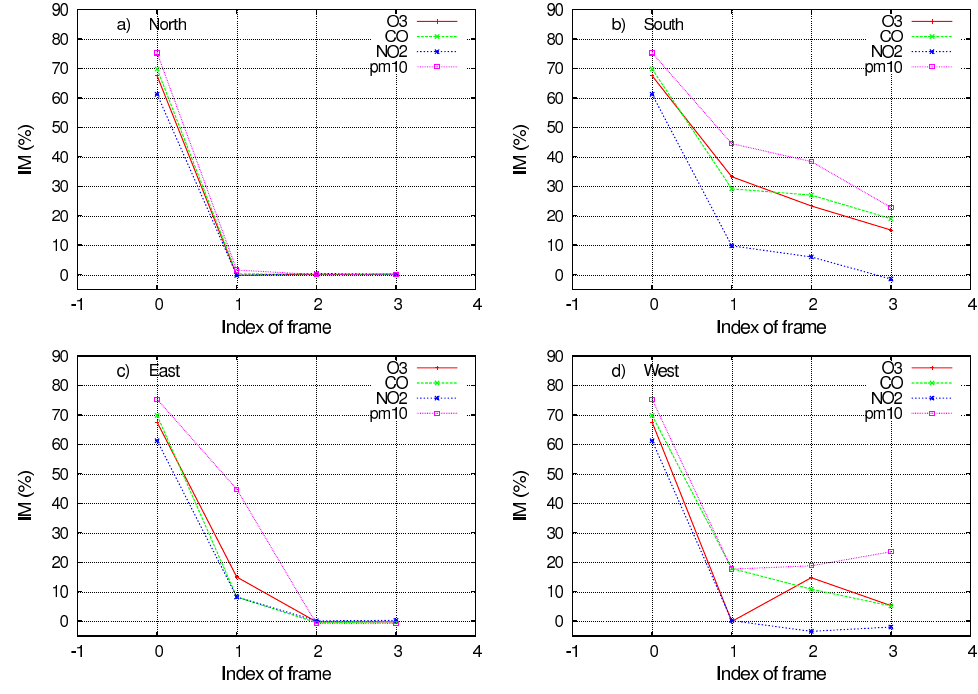
Fig. 7. Daily statistics for the case study 2005-06-17. From left to right, from top to bottom: North (a) , South (b) , East (c) and West (d) sides of the three frames (value for core is unique).